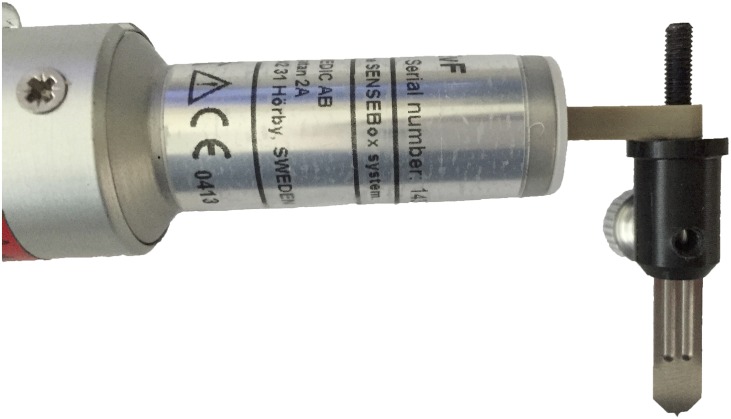
The setup of the SPT lancet attached to the SENSEBox Electronic von Frey weight transducer.